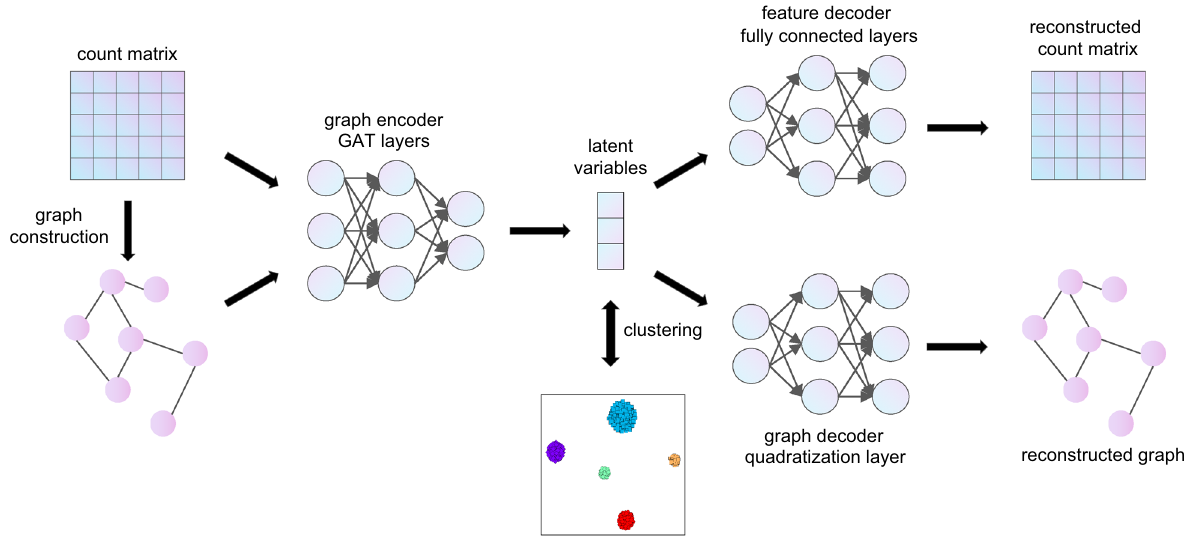
Figure 1. The model architecture of scGAE. The normalized count matrix represents the gene expression level in each cell. The adjacency matrix is constructed by connecting each cell to its K nearest neighbors. The encoder takes the count matrix and the adjacency matrix as inputs and generates low-dimensional latent variables. The feature decoder reconstructs the count matrix. The graph decoder reconstructs the adjacency matrix. Clustering is performed on the latent